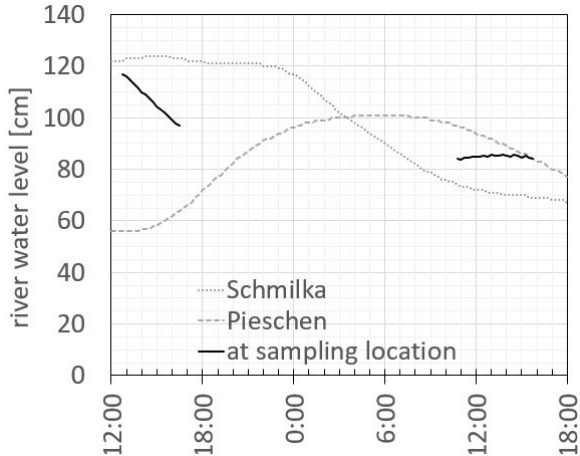
Figure 6. River water level (i) recorded at stations in Schmilka and Pieschen and (ii) interpolated for the sampling location of the cruising vessel during the second cruise with the first data point located 4 km downstream of Schmilka (11–12 September 2018).